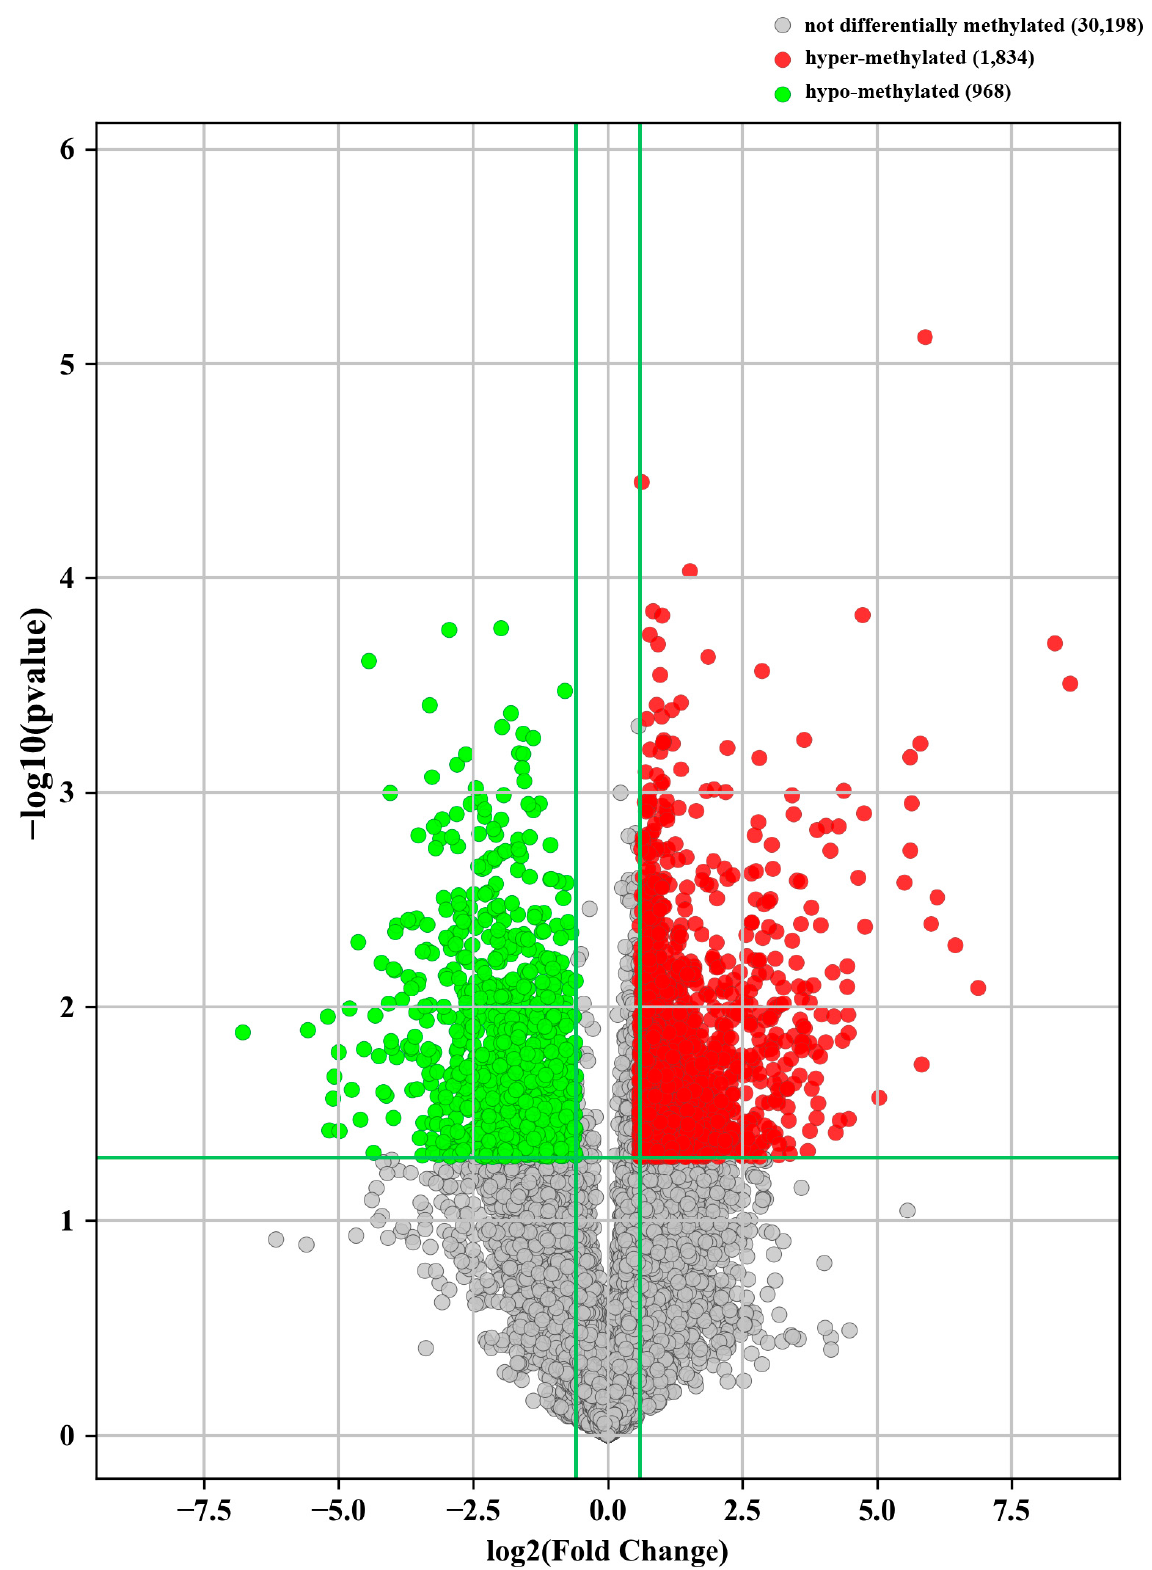
Figure 4. Volcano plot showed there were 2802 differentially methylated mRNAs (FC > 1.5, p < 0.05; with 1834 hypermethylated mRNAs and 968 hypomethylated mRNAs).